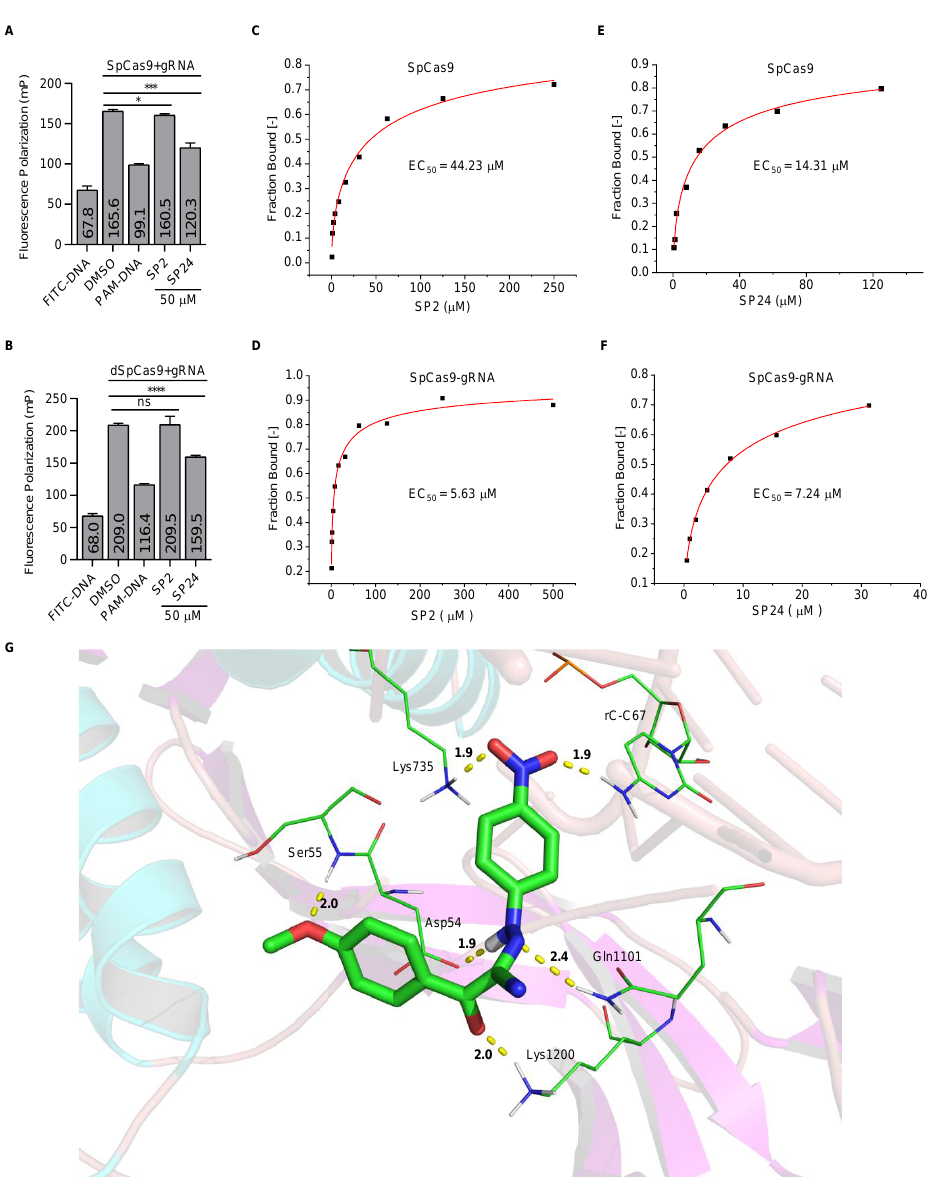
Figure 5. Investigating the inhibition mechanisms of the identified compounds. ( A , B ) Each compound (50 nM) was added to a SpCas9-gRNA (1:1) ( A ) or dSpCas9-gRNA (1:1) ( B ) mixture before addition of the FITC-labeled target DNA (25 nM). Fluorescence polarization was assessed by a multilabel reader within 10 min. FITC-DNA, FITC labeled double-stranded target DNA. PAM-DNA, unlabeled double-stranded target DNA (1.25 µ M). Error bars represent mean ± SD (n = 3). The p values were determined by two-tailed unpaired t -test, ns means no significance, (*) p < 0.05, (***) p < 0.001, and (****) p < 0.0001. ( C – F ) For MST assays, the compounds were titrated with SpCas9 or SpCas9-gRNA as indicated. The concentration of SpCas9–EGFP fusion protein was 200 nM. The mixture was kept at room temperature for 10 min. Then the sample was loaded into the NanoTemper standard capillaries. The EC 50 of SP2 to SpCas9 and SpCas9–gRNA RNP complex is 44.23 ± 35.40 µ M ( C ) and 5.63 ± 3.65 µ M ( D ), respectively. The EC 50 of SP24 to SpCas9 and SpCas9–gRNA complex is 14.31 ± 6.9 µ M ( E ) and 7.24 ± 3.16 µ M ( F ), respectively. ( G ) We propose that SP24 inserts into the active site of SpCas9 (PDB: 4ZT9). The ribbons represent SpCas9 or gRNA. The green rod in the middle represents compound SP24. Amino acid residues or bases that interact with the compound are represented by green lines. The yellow dashed lines represent the hydrogen bond interaction between the compound and the SpCas9–gRNA complex. Carbon, nitrogen, oxygen, and hydrogen atoms are shown in green, blue, red, and white,